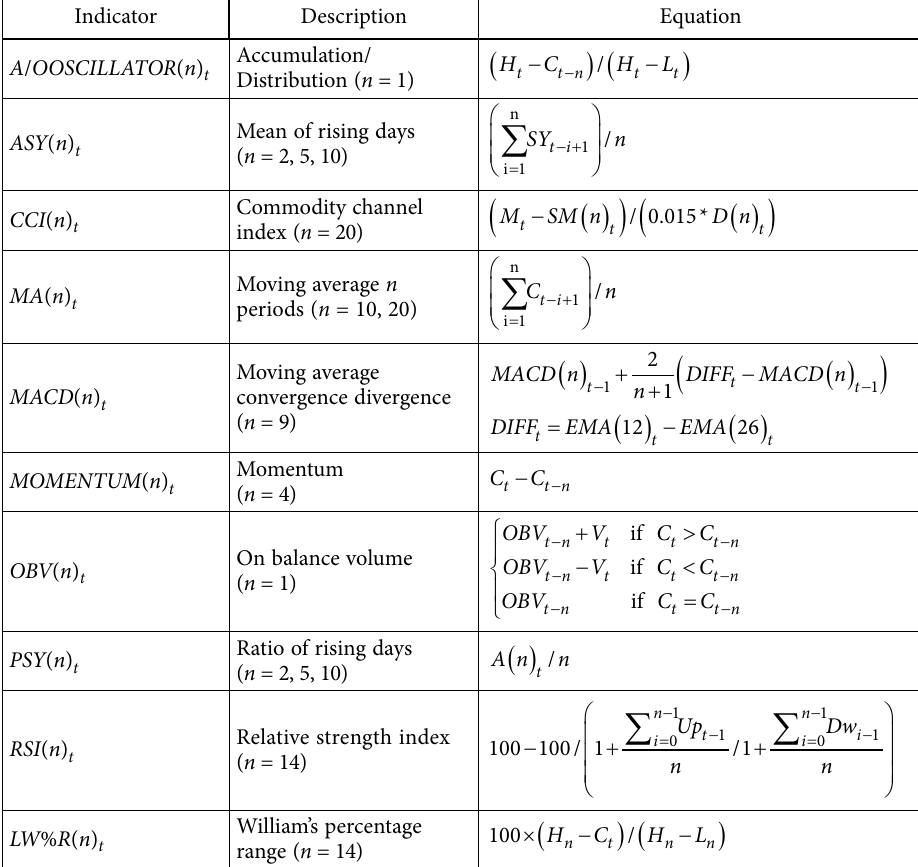
Table 1. Selected variables employed in the study